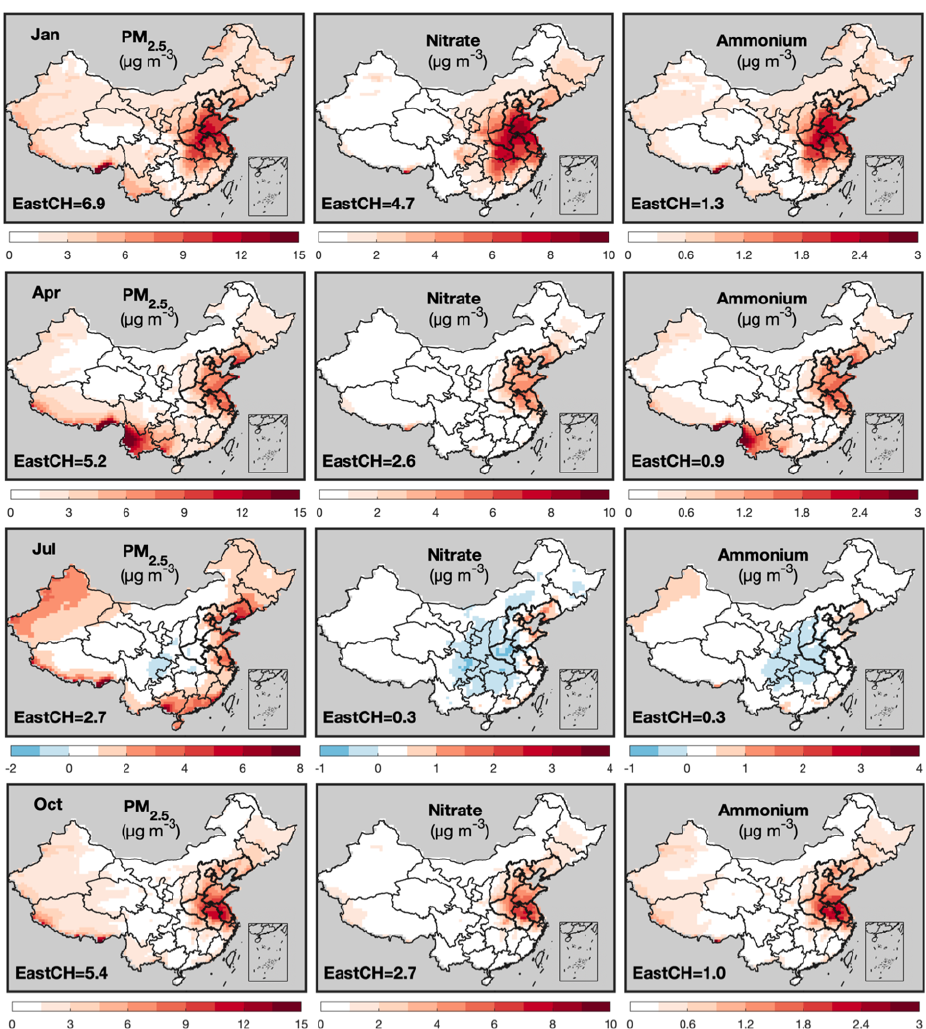
Figure 4. Same as Fig. 3, but for January, April, July, and October as denoted by text in the top left corner of each row.